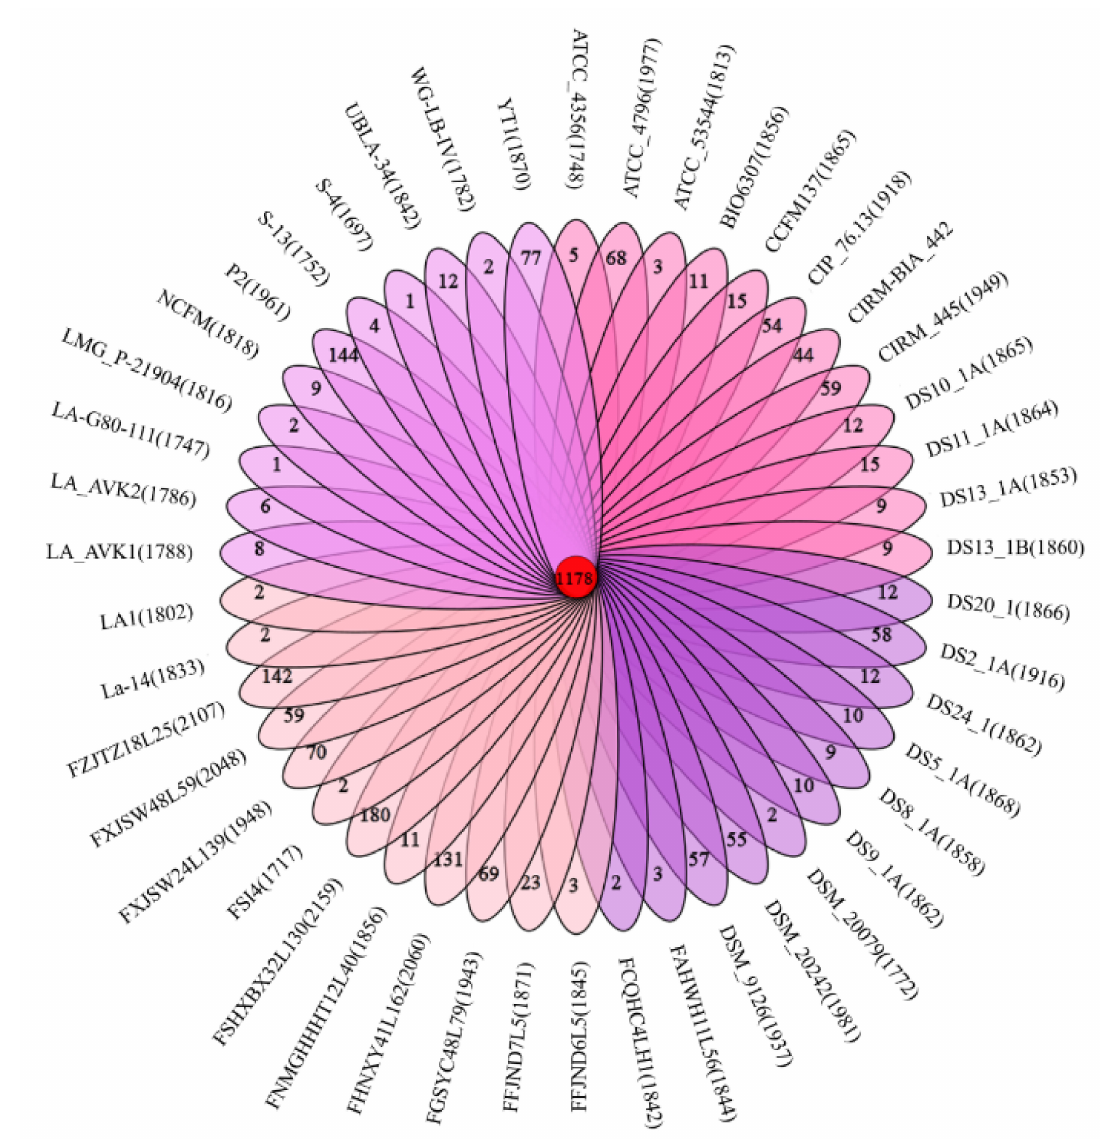
Figure 2. Venn diagram of L. acidophilus . The middle circle of the Venn diagram shows the number of homologous genes of these 46 L. acidophilus . Additionally, every branch shows the number of their unique